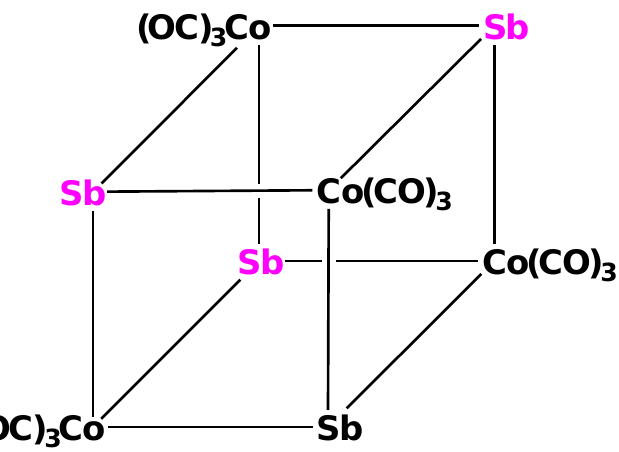
Figure 9. Schematic view of the structure of complex 12 [39].